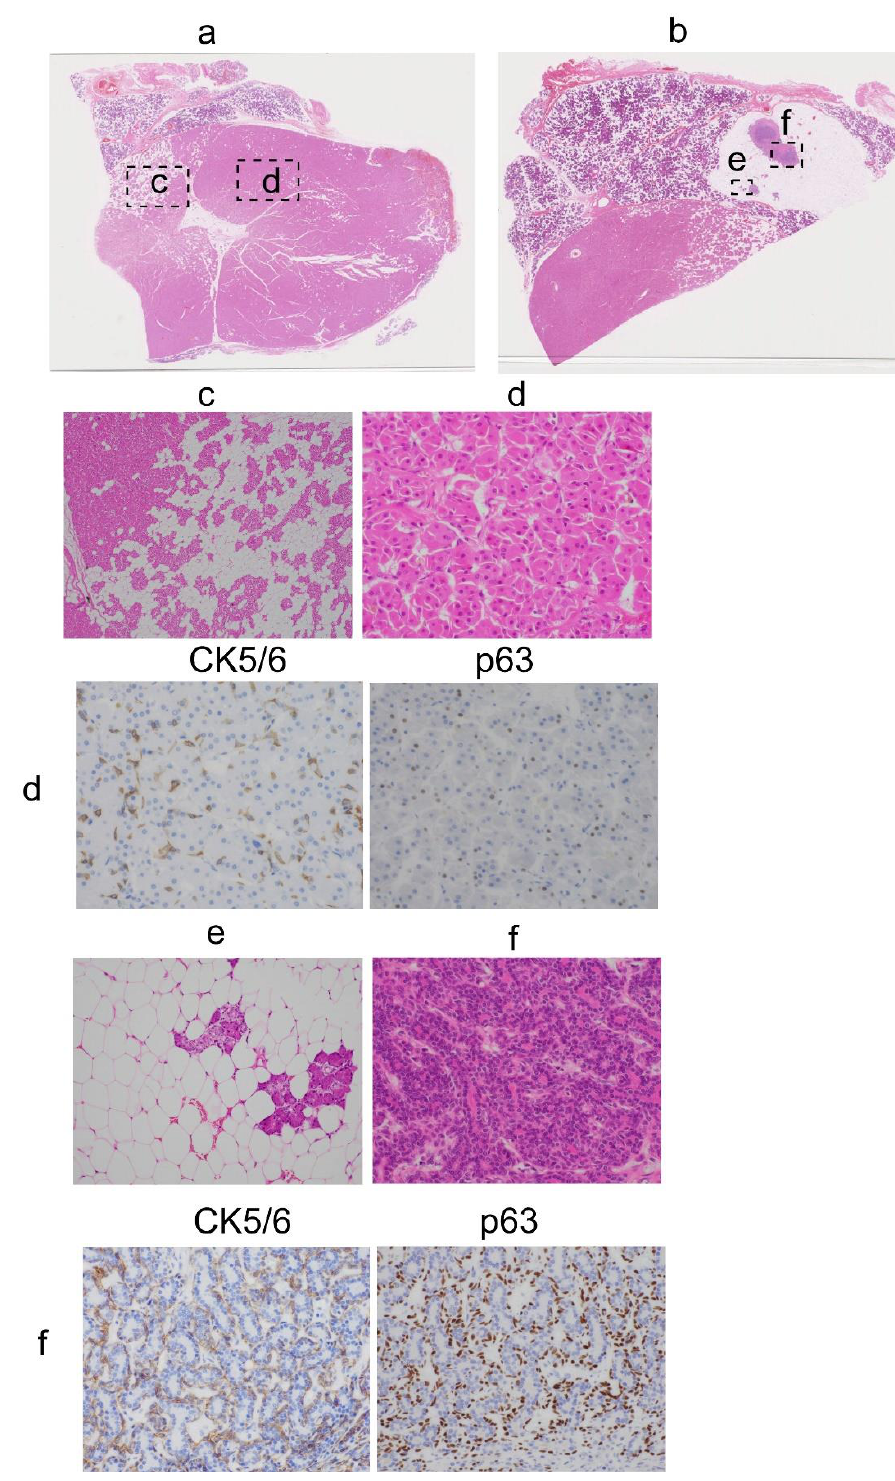
Figure 2. Histological aspects of oncocytic lipoadenoma. ( a , b ) Representative HE images were taken by virtual slide. Inset dot boxes were taken by microscope as below. ( c ) Mixed oncocytic and lipomatous components of the tumor. 40 × magnification. ( d ) Large magnification of oncocytes. Immunoreactivities of CK5/6 and p63 in the oncocytic component. 400 × magnification. ( e ) Acinar glands in non-oncocytic lipoadenoma. ( f ) Proliferated ductal cells in non-oncocytic lipoadenoma. Immunoreactivities of CK5/6 and p63 in ducts “nodule-in-nodule“ structure. 400 × magnification.